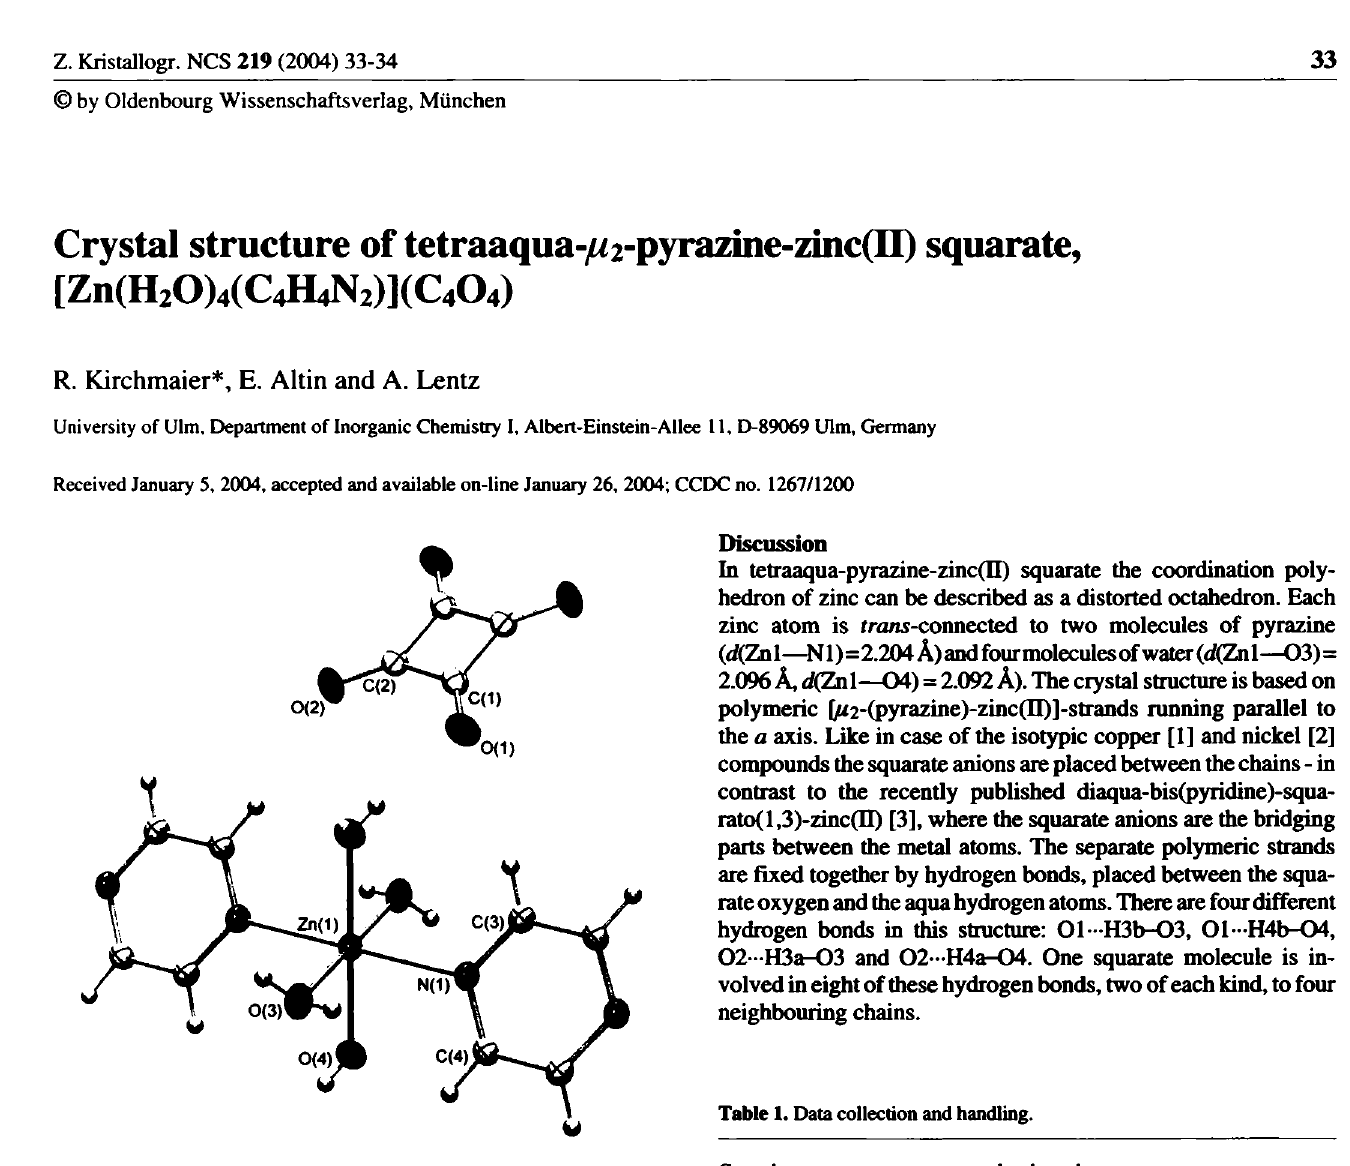
Table 2. Atomic coordinates and displacement parameters (in Â 2